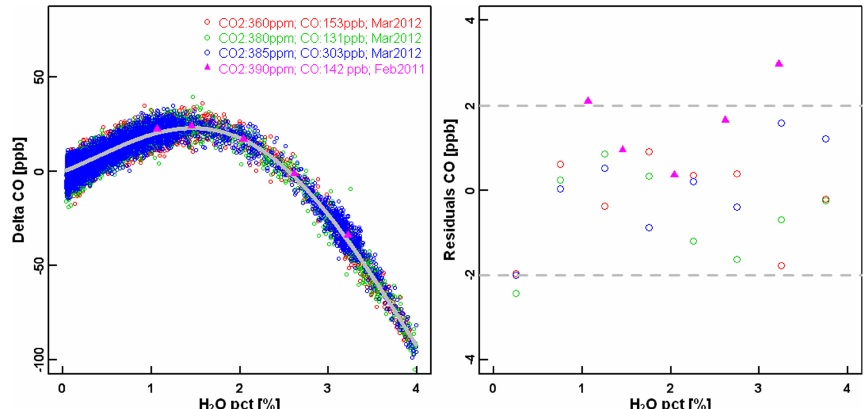
Fig. 3. Fourth-order fit of water droplet test data with 360–390ppm CO 2 (red, green, and blue), 1 CO vs. H 2 O mole fractions for the range of 0–4%. The experimental data were weighted based on the density of the measurements in the water vapor domain so that equal water vapor range contributed equally to the curve fit. The pink solid triangles are averaged values of 1 CO obtained using water test method #1 in February 2011, and cover a water vapor range of 1–3.2% at discrete water vapor levels. The residuals from the fit for each water test, averaged over 0.5% H 2 O intervals, are shown in the right